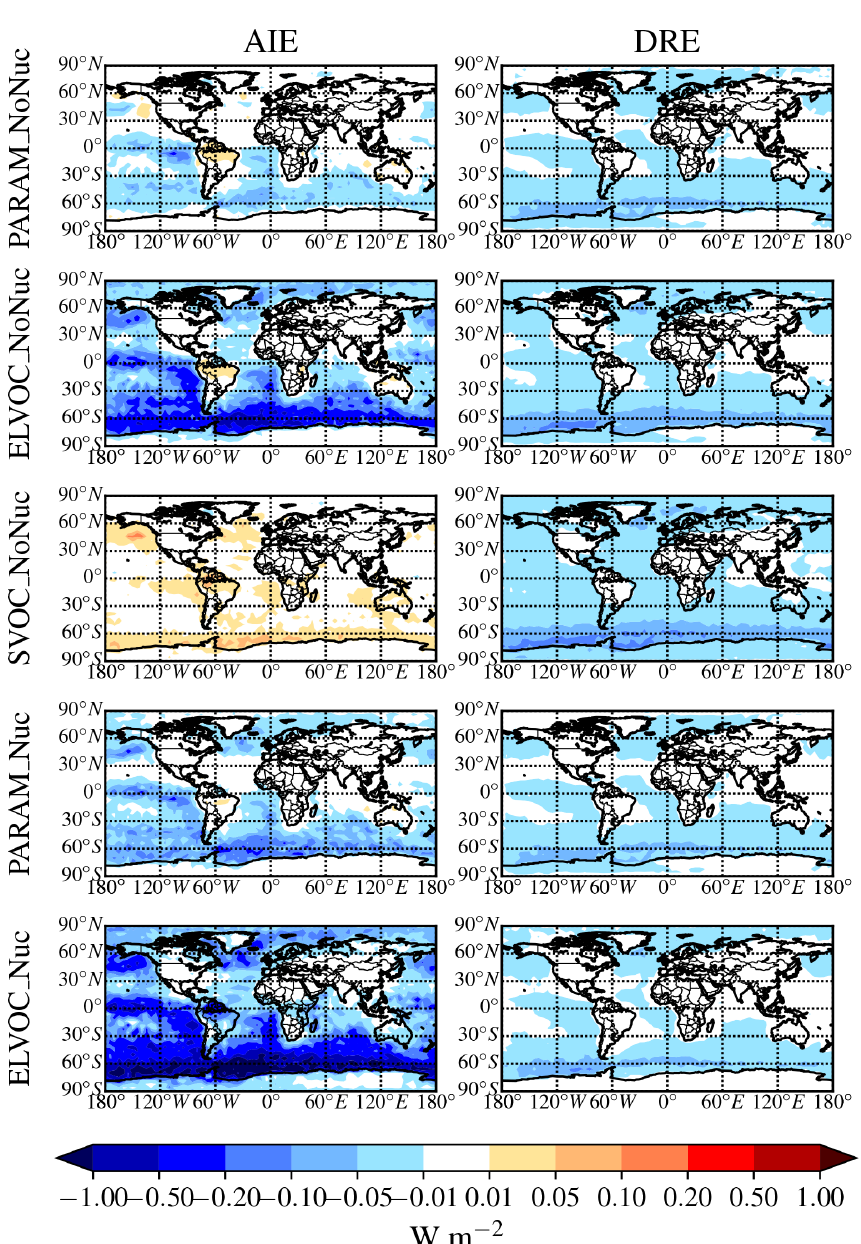
Figure 4. Global annual mean change in Wm − 2 for the aerosol indirect effect (cloud-albedo AIE, denoted as “AIE”; first column) and the direct radiative effect (DRE; second column) between DEFAULT_NoMSA and PARAM_NoNuc (first row), ELVOC_NoNuc (second row), SVOC_Nuc (third row), PARAM_Nuc (fourth row), and ELVOC_Nuc (fifth row) (warm colors indicate an increase in the AIE/DRE as compared to